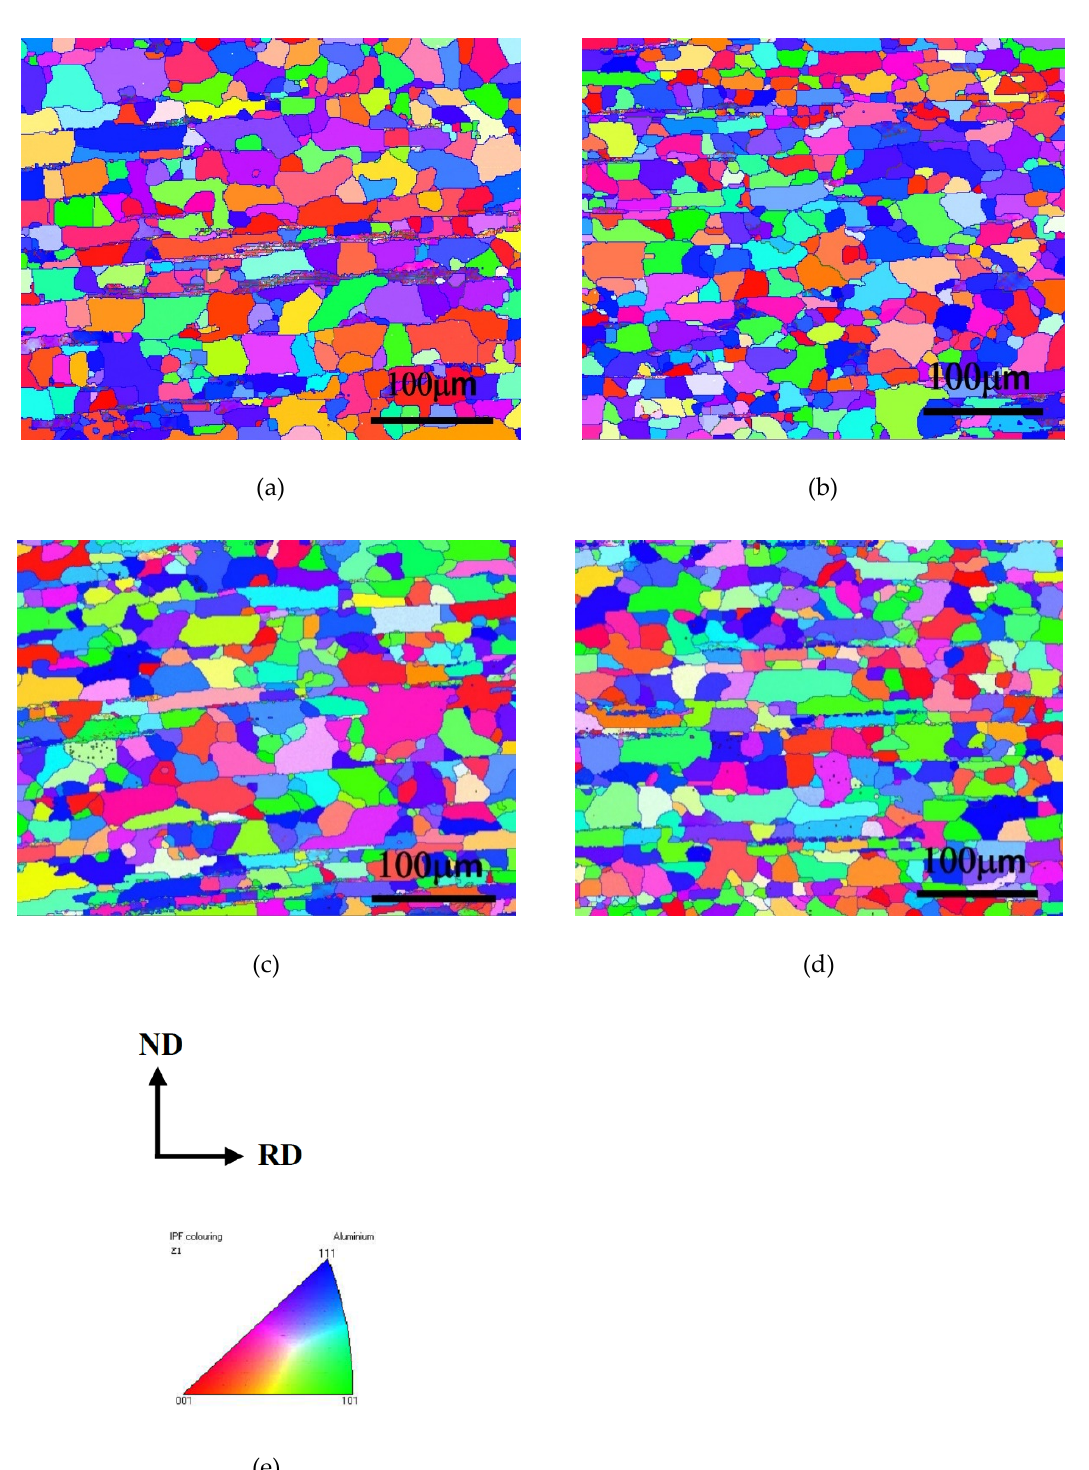
Figure 7. EBSD analysis of Alloy B (0.8Mn) after ( a ) 1-Homo 400 °C annealing for 0.5 h; ( b ) 1-Homo 400 °C annealing for 1 h; ( c ) 2-Homo 400 °C annealing for 0.5 h; ( d ) 2-Homo 400 °C annealing for 1 h; ( e ) IPF coloring map and rolling direction. 1 h; ( c ) 2-Homo 400 ◦ C annealing for 0.5 h; ( d ) 2-Homo 400 ◦ C annealing for 1 h; ( e ) IPF coloring map and rolling